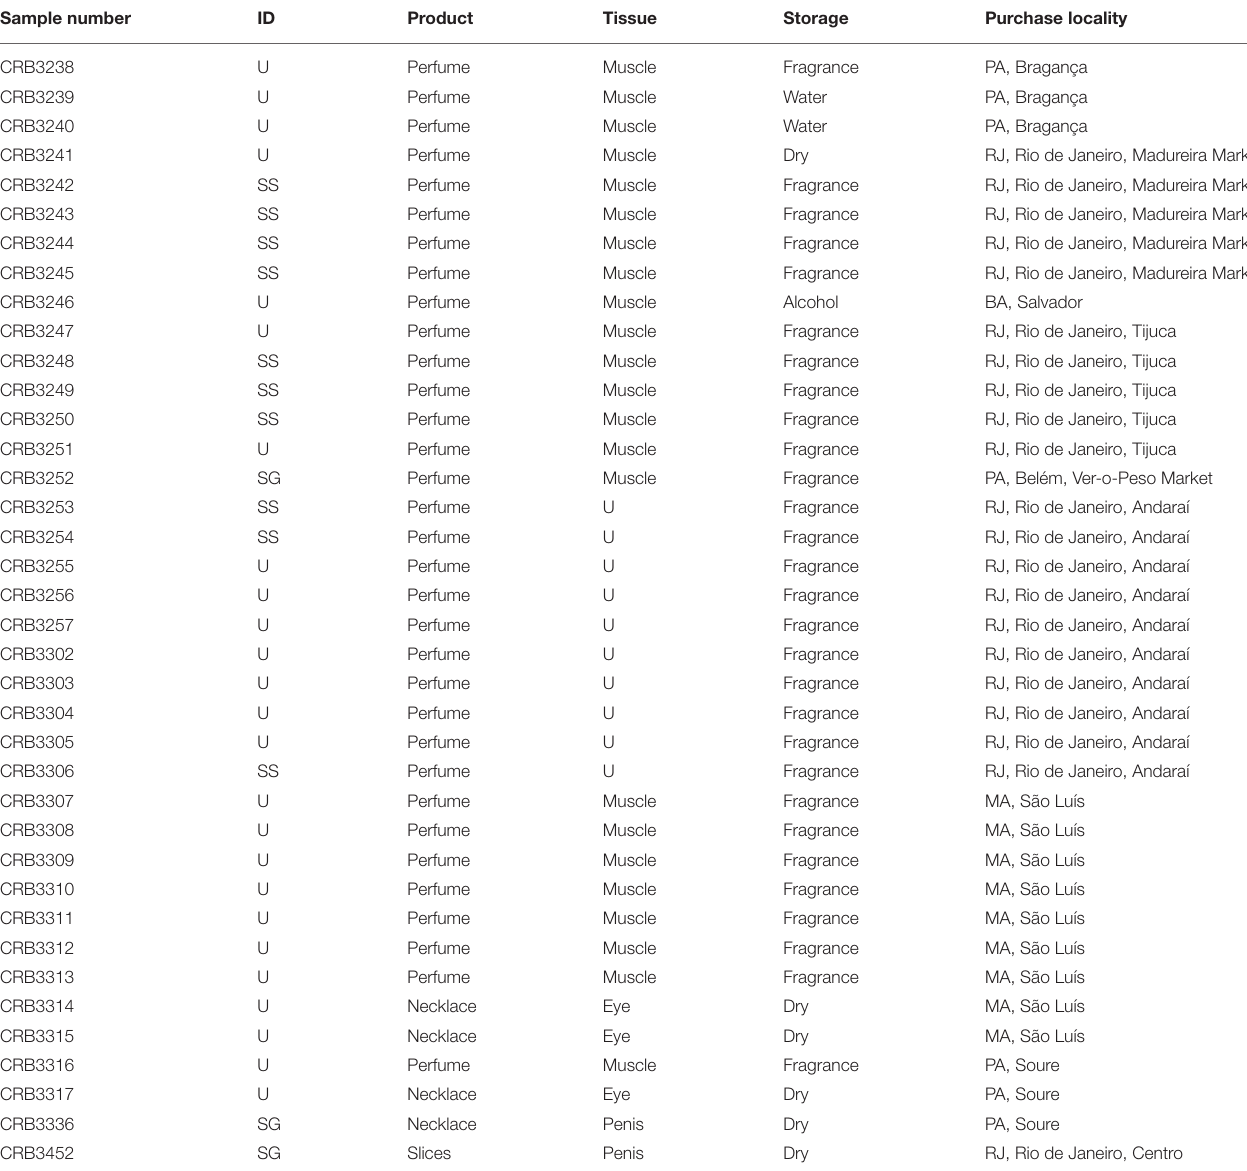
TABLE 1 | Dolphin love charm samples, with sample number, identification (ID), type of product, tissue, storage, and purchase